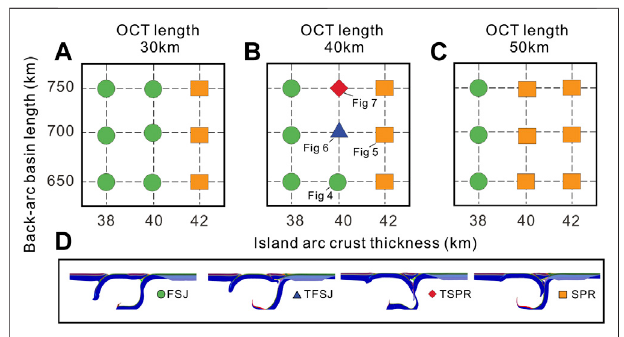
modeling results of the forward subduction jumping model (FSJ); orange squares represent the subduction polarity reversal model (SPR); the red diamonds correspond to numerical model results that the parallel triple subduction model tends to polarity reversal (TSPR); and dark blue triangles represent that the parallel triple subduction model tends to the jumping model (TFSJ). Panel (D) shows the four different types of model